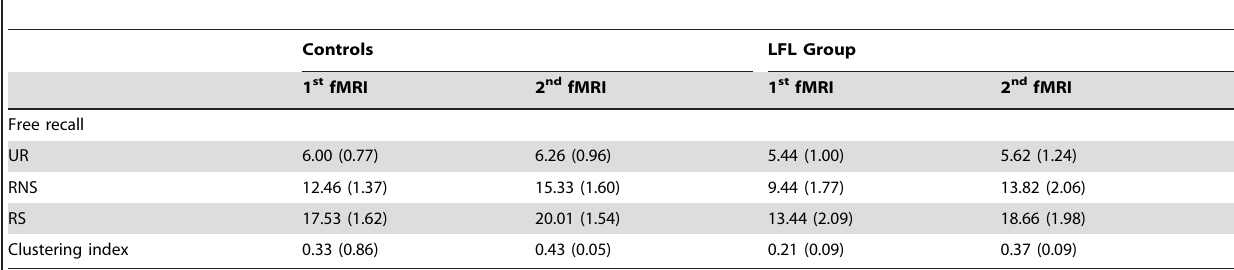
Table 3. Memory performance measured during the 1 st and 2 nd fMRI sessions for the healthy controls and LFL group.